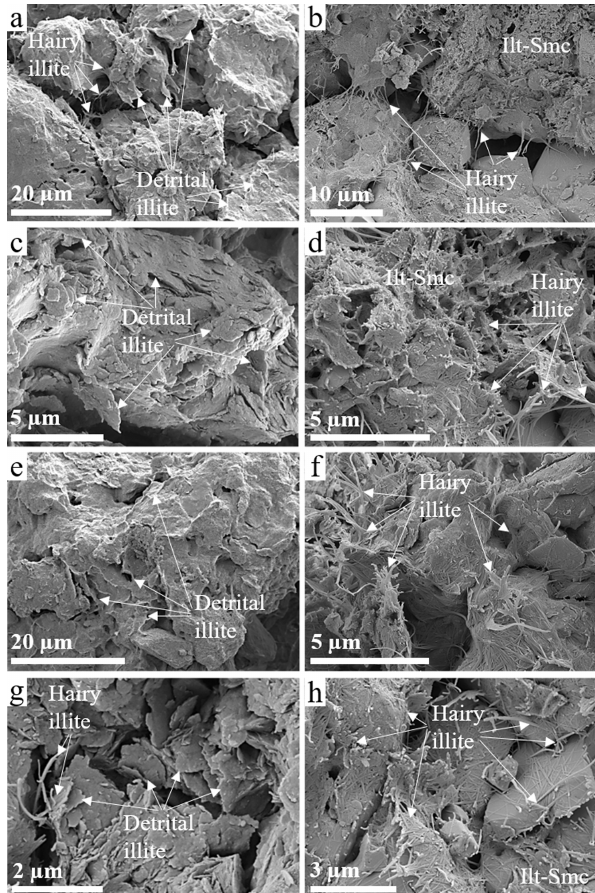
Figure 4. Secondary electron images of partly calichized and illi- tized silty to sandy deposits from the of the Oligocene Hsanda Gol Formation, Valley of Lakes, collected from the (a–b) TAT section ( ∼ 90 . 5m), (c–d) TGR-C section ( ∼ 78 . 0m), (e–f) SHG-D sec- tion ( ∼ 55 . 5m) and (g–h) TGR-AB section ( ∼ 35 . 0m). The detri- tal illite/muscovite (a, c, e, g) occurs as coarse, rounded or pseu- dohexagonal platelets, whereas authigenic illite–smectite (Ilt–Smc) and hairy illite (b, d, f, h) appear either as fine, flaky to irregular particles or as long but thin laths and fibres, both covering detrital grains or growing into the open